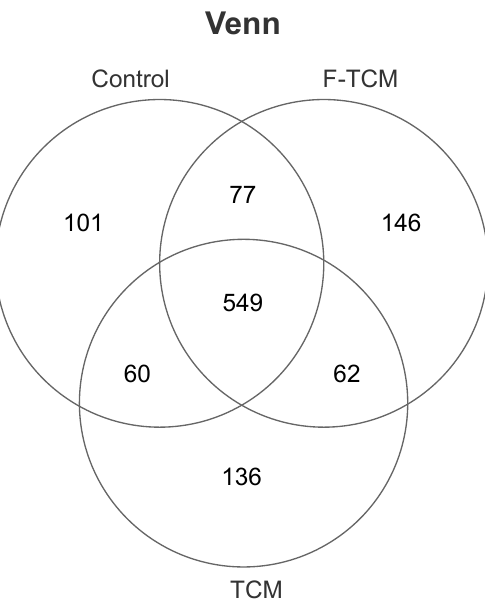
Figure 2. Venn diagram analysis of the OTUs among the treatment groups. At the phylum level, Bacteroidetes and Firmicutes were the predominant phyla in the fecal microbiota of piglets, with a total abundance of >95%, followed by the phyla Actino- bacteria and Proteobacteria (Figure 3A,D).